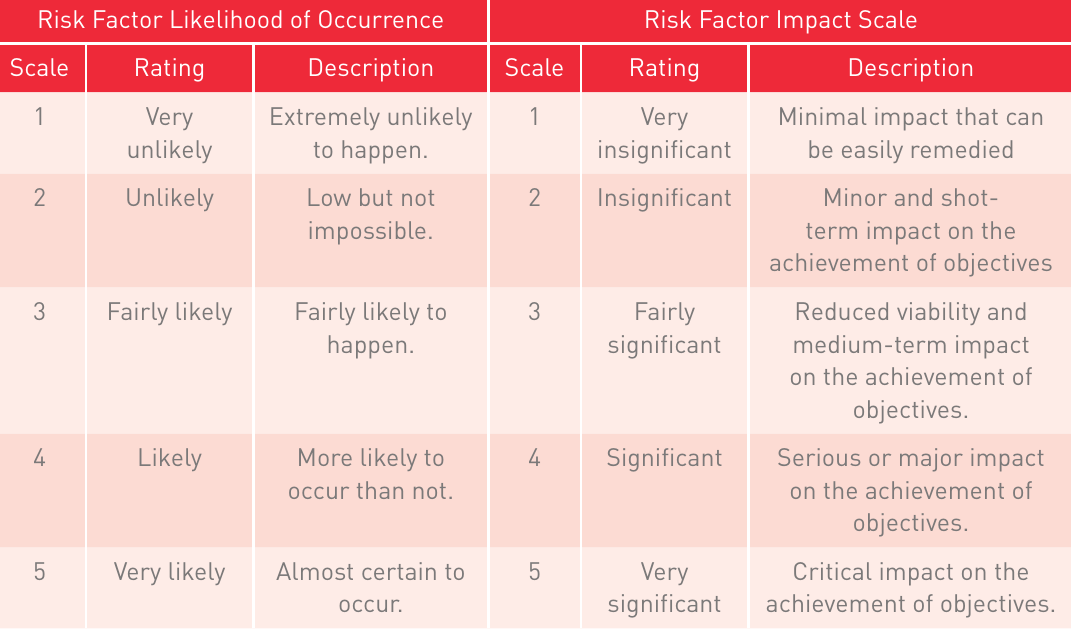
Risk Factor Likelihood of Occurrence and Risk Factor Impact Scales